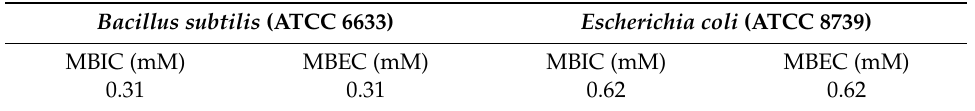
Table 3. The minimum biofilm inhibitory concentration (MBIC) and minimum biofilm eradication concentration of the SCGS against di ff erent standard developed bacterial biofilms. The result was represented as the mean of the sample concentrations (mM) with zero standard deviations (SD).